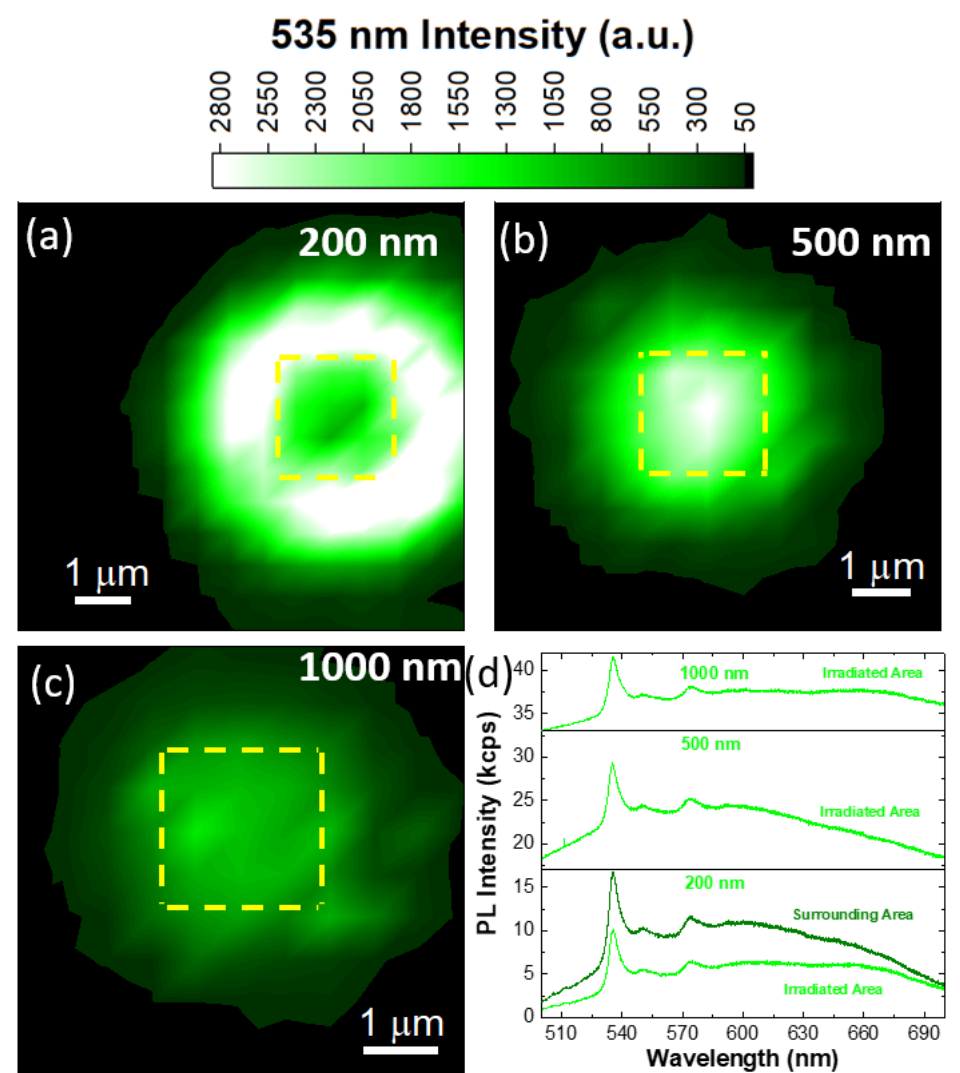
Figure 4. PL intensity map acquired at 535 nm for the 200 nm ( a ), 500 nm ( b ) and 1000 nm ( c ) spaced patterns. The upper color bar applies for all the maps. ( d ) PL spectra of the 15 keV electron-irradiated hBN with different pattern spacings.